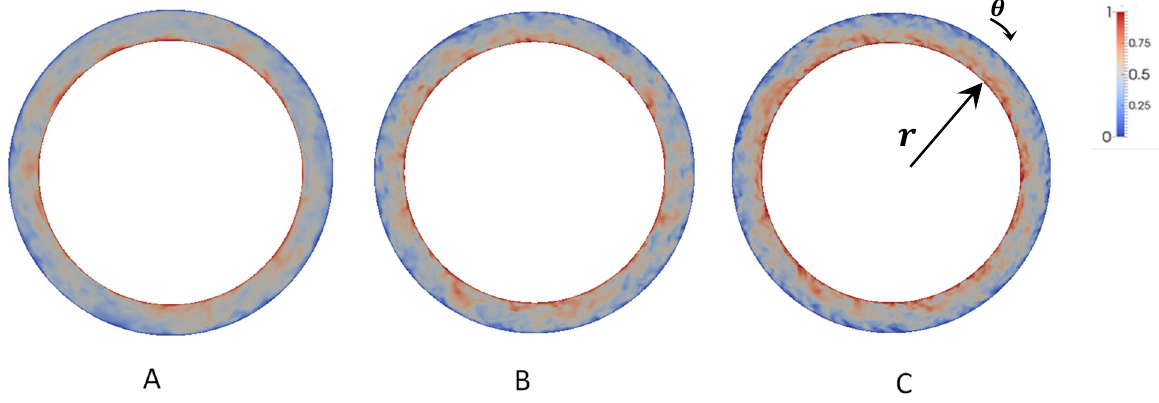
Figure 7. Velocity fields of the spanwise component in a section of the annular geometry for N = 5.12 case ( A ), N = 1.71 case ( B ), and N = 0.85 case ( C ) .